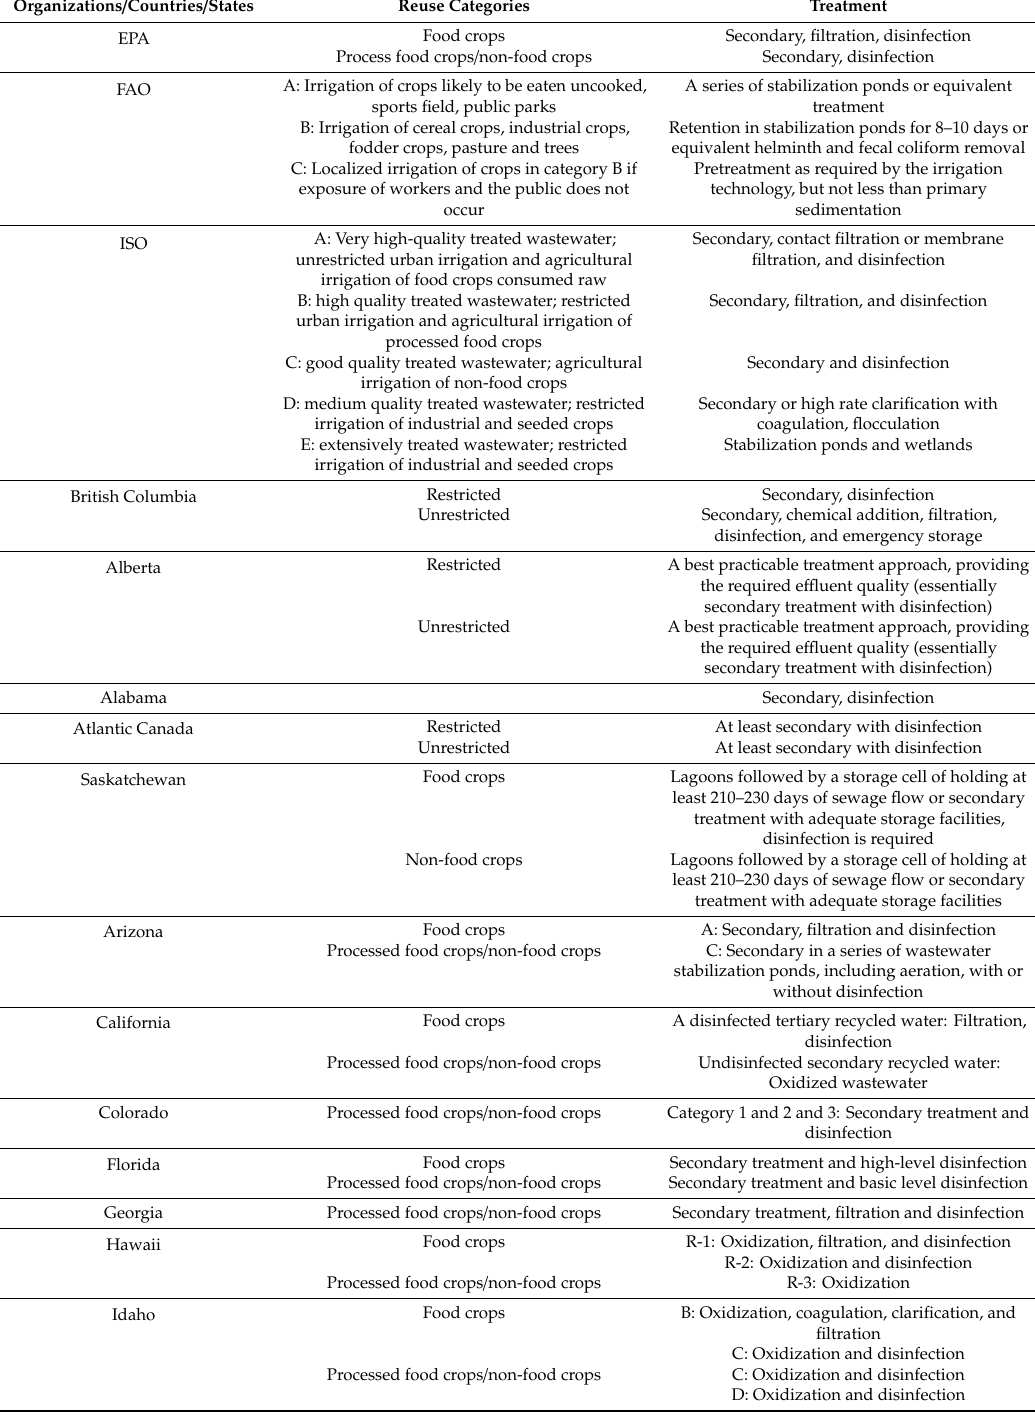
Table 20. Required treatment technologies in agricultural water reuse regulations and